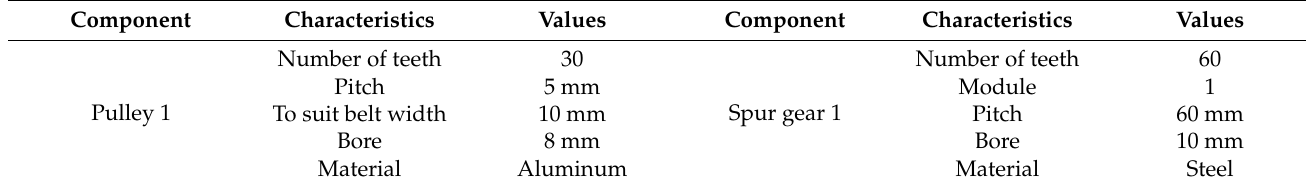
Table A1. Technical characteristics of components included in the test